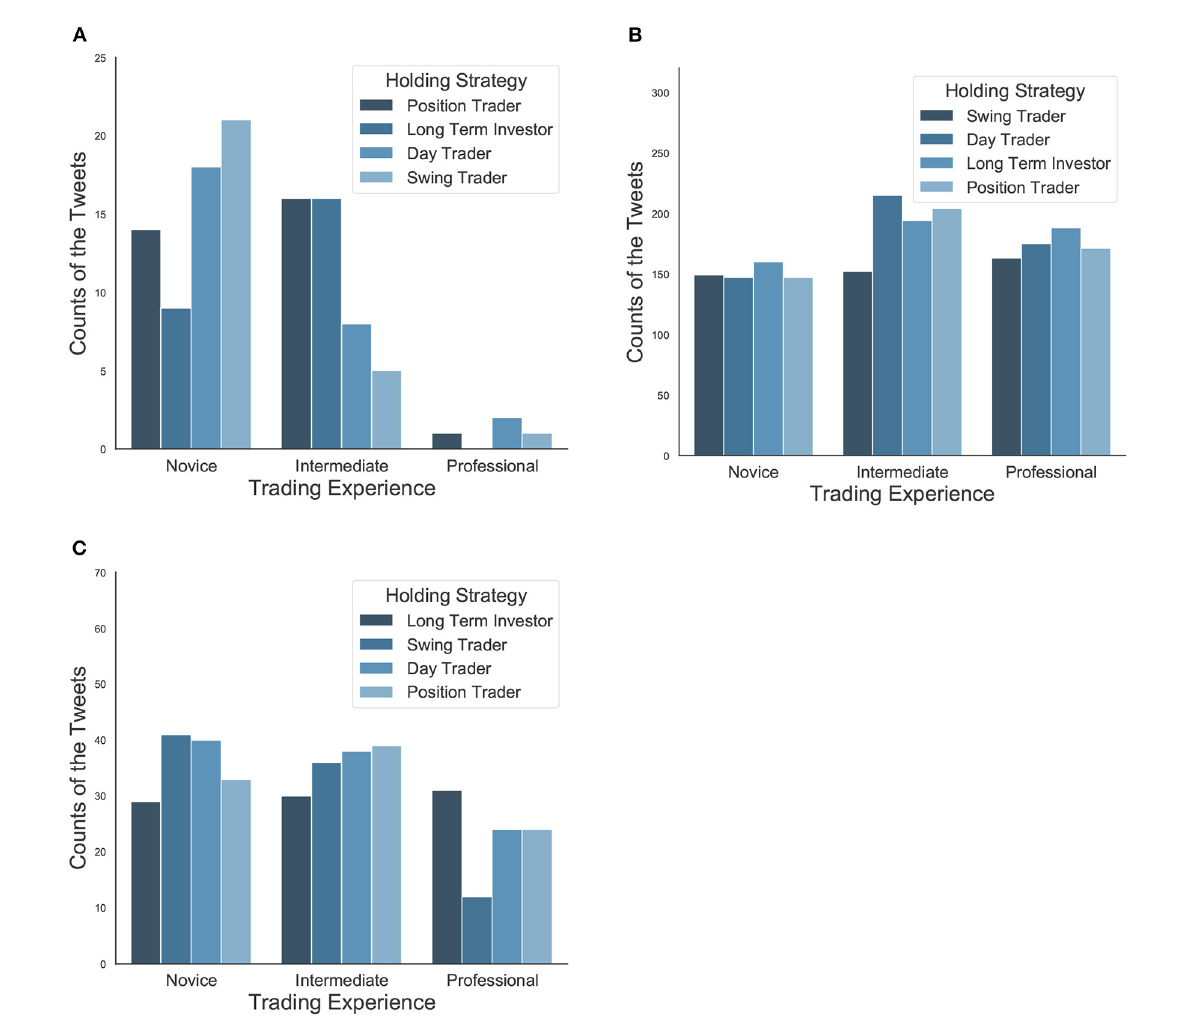
FIGURE6 (A) The distribution of tweet proportion according to investor trading experience and holding strategy on Topic 2 [FDA Drug Approval (Vascepa)]. Novice investors are more likely to discuss this topic than intermediate and professional traders. (B) The distribution of tweet proportion according to investor trading experience and holding strategy on Topic 9 (Greek Debt Crisis). It is a hot topic for all types of investors with different profiles in terms of a large number of tweets. (C) The distribution of tweet proportion according to investor trading experience